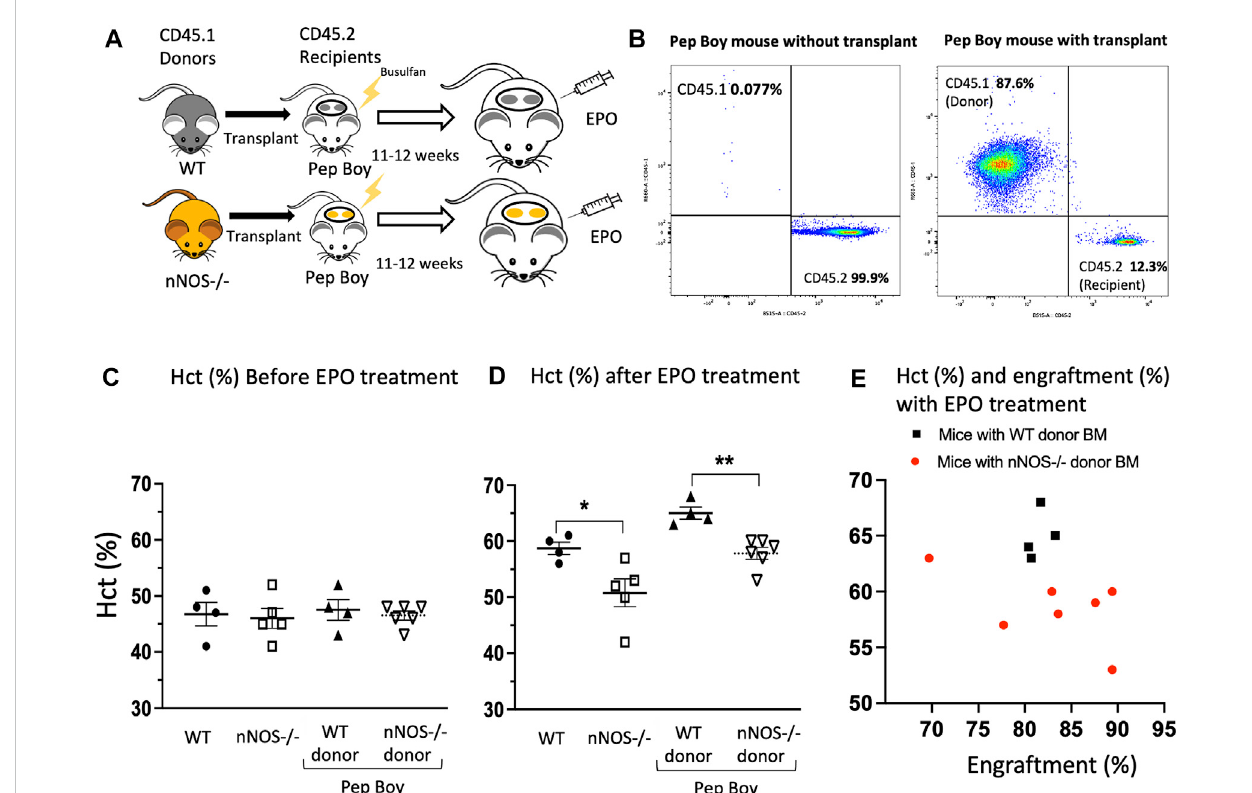
FIGURE 2 EPOstimulatederythropoiesisinmicetransplantedwith nNOS − / − bonemarrow.Micetransplantedwith nNOS − / − bonemarrowexhibitedablunted erythropoietic response to EPO treatment with a smaller increase in hematocrit compared to mice that received WT donor marrow. (A) Bone marrow from WT (CD45.1) and nNOS − / − (CD45.1) donor mice was transplanted into Pep Boy (CD45.2) recipient mice. (B) Representative FACS plots for CD45.1andCD45.2cellsfromperipheralbloodofPepBoymicewithtransplantfromnNOS − / − miceandwithouttransplant.Engraftmentef fi ciency was measured after 10 – 11 weeks following transplant. (C,D) Hematocrit levels (%) in WT and nNOS − / − mice and in Pep Boy recipient mice transplanted with WT and nNOS − / − donor marrow were assessed before (C) and after (D) 1 week of EPO treatment (3000 U/kg; 3 times per week). Only mice with more than 70% transplant rate were analyzed. (E) Hematocrit levels (%) were plotted with engraftment (%) for recipient Pep Boy mice with WT (black squares) and nNOS − / − (red circles) donor